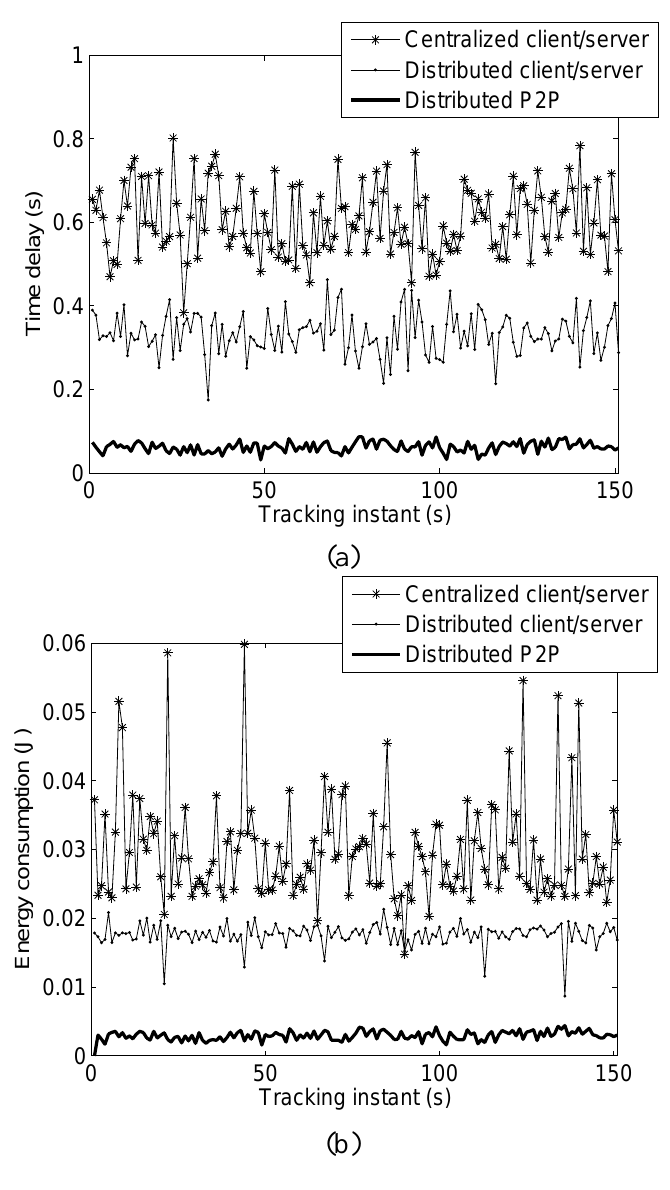
Figure 9. Comparison between centralized client/server framework, distributed client/server framework and distributed P2P framework in (a) time delay and (b) energy